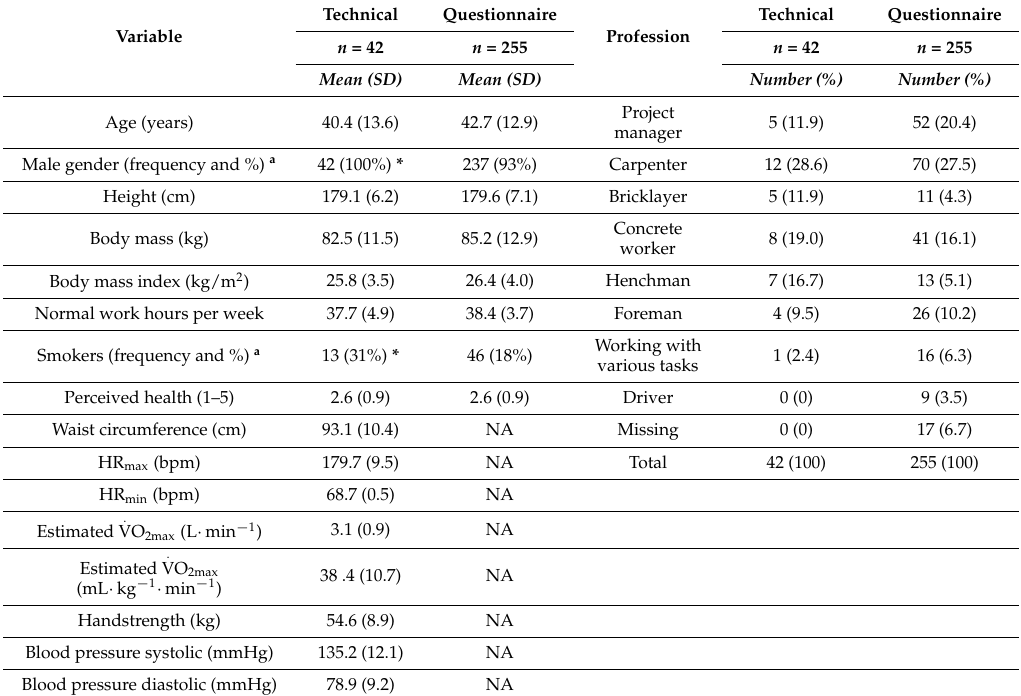
Table 1. Characteristics of the study population divided in technical and questionnaire groups. Technical Variable